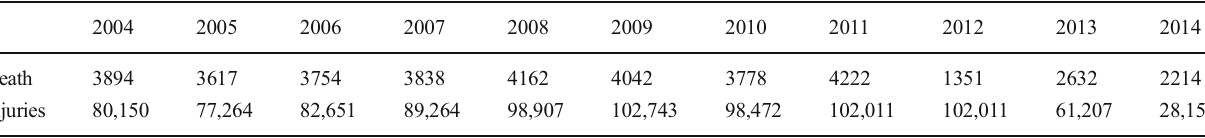
Road accident statistics in Morocco between 2004 and